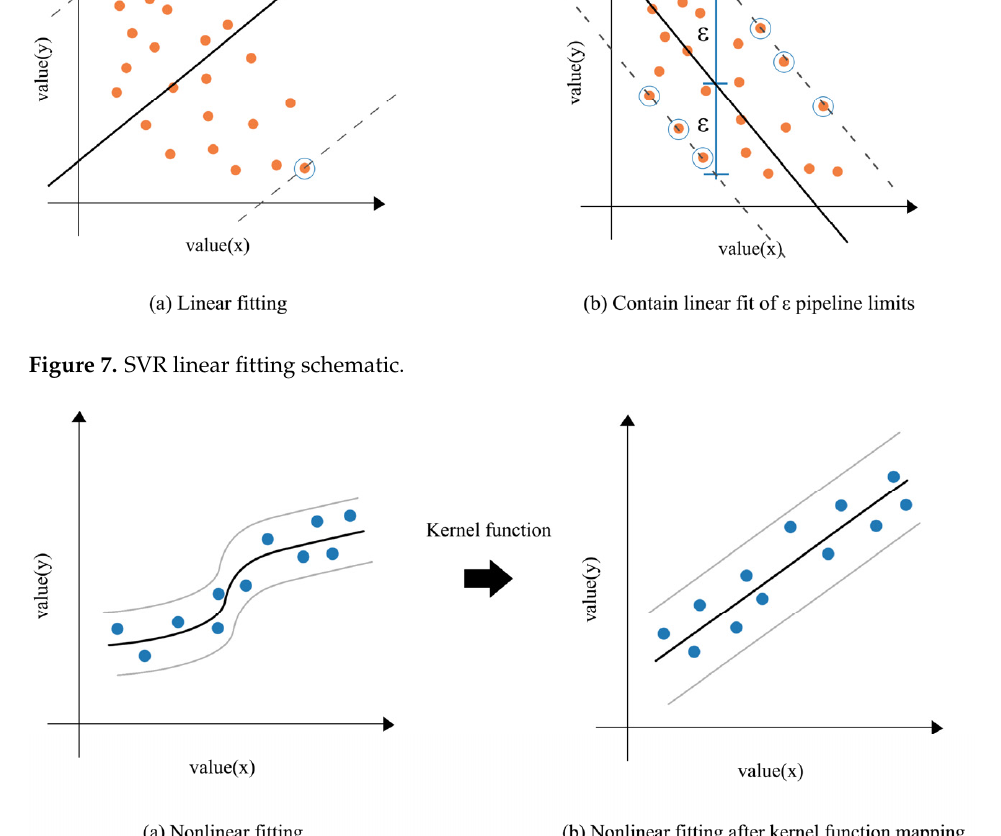
Figure 9. SVM battery pack.